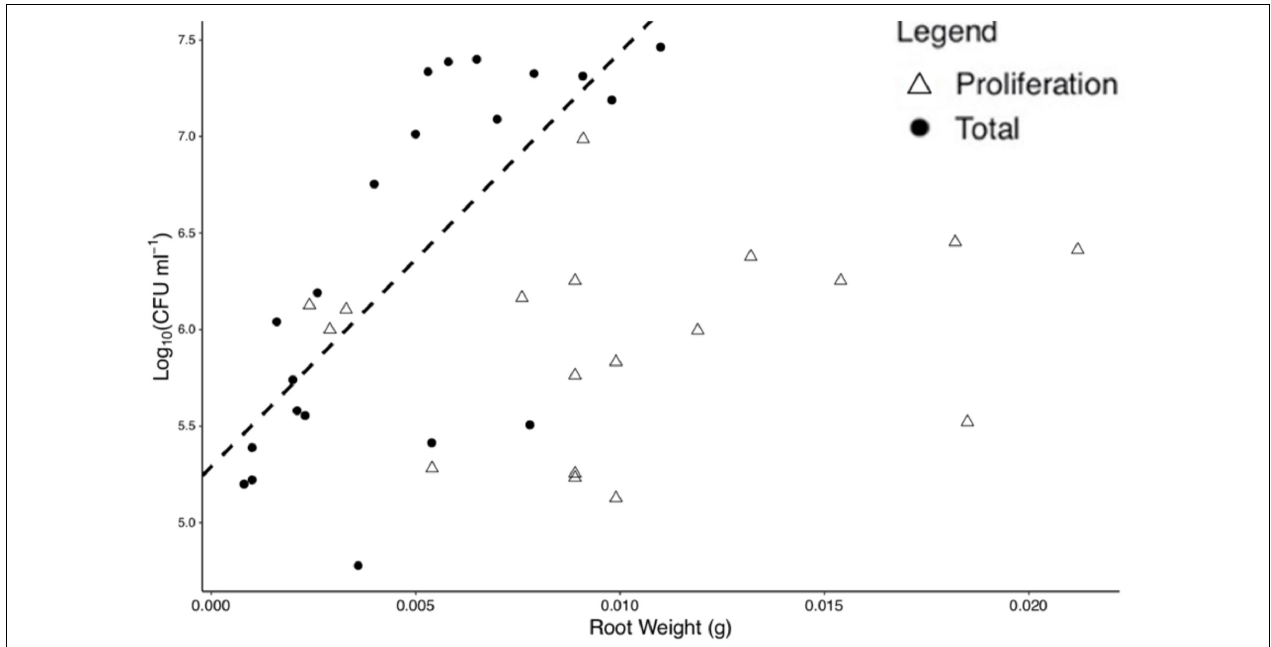
FIGURE 3 | Bacterial numbers on the rhizoplane and root weight are positively correlated for total colonization at 96 h. Each point represents an individual destructive measurement of root weight and Log 10 (CFU) on the root surface. A significant linear relationship was found for total colonization density at 96 h but not for proliferation data. The dashed line represents the linear model for total colonization (slope = 214.551 Log 10 (CFU) ml - 1 , intercept = 5.291 Log 10 (CFU) ml - 1